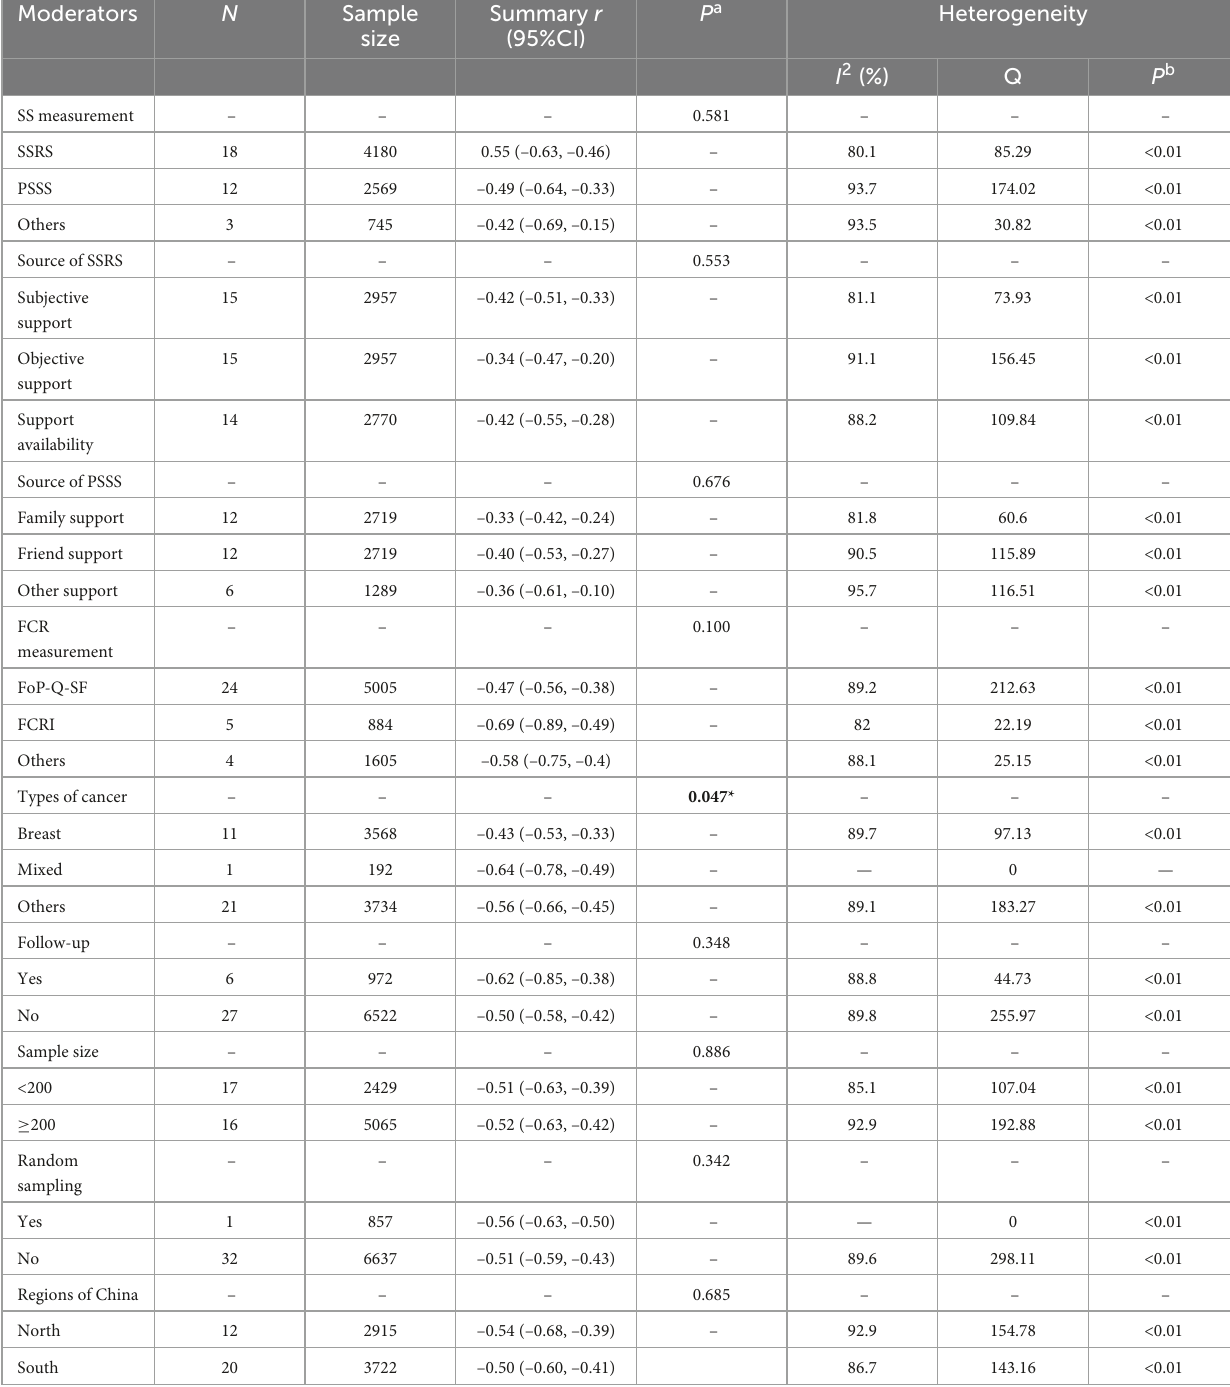
TABLE 4 Subgroup analysis of the summary r coefficient between social support (SS) and fear of cancer recurrence (FCR). Moderators N Sample